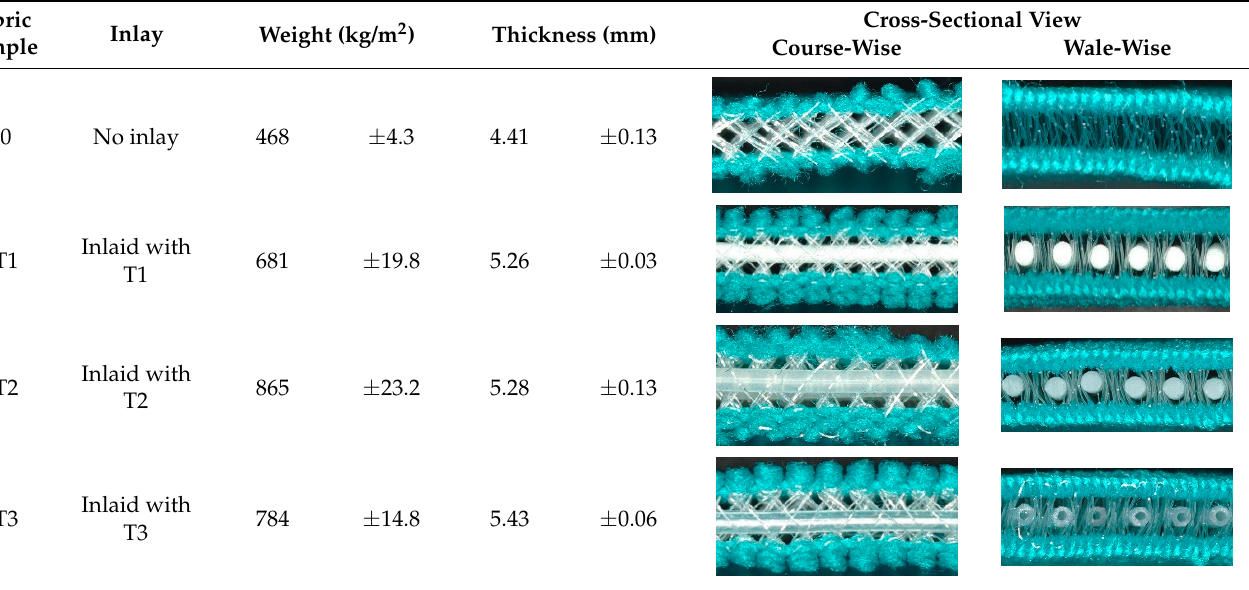
Figure 1. Yarn path diagram of the spacer fabric samples with inlaid tubes.